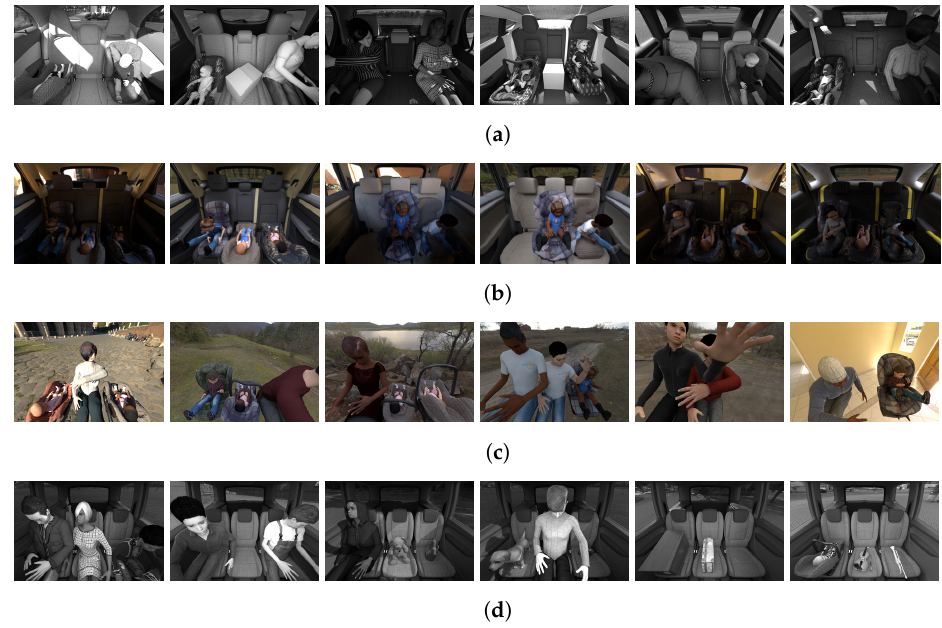
Figure 2. Example images for the different SVIRO datasets variations. Each seat position (left, middle and right) can be empty, or an adult, a child seat, an infant seat or an everyday object can be placed on it. ( a ) SVIRO: Base dataset with sceneries for ten different vehicle interiors. ( b ) SVIRO-Illumination: Scenery is rendered under several illuminations conditions. ( c ) SVIRO-NoCar: Scenery is rendered with different background and without a vehicle. ( d ) SVIRO-Uncertainty: Fine-grained splits with unknown everyday objects for uncertainty